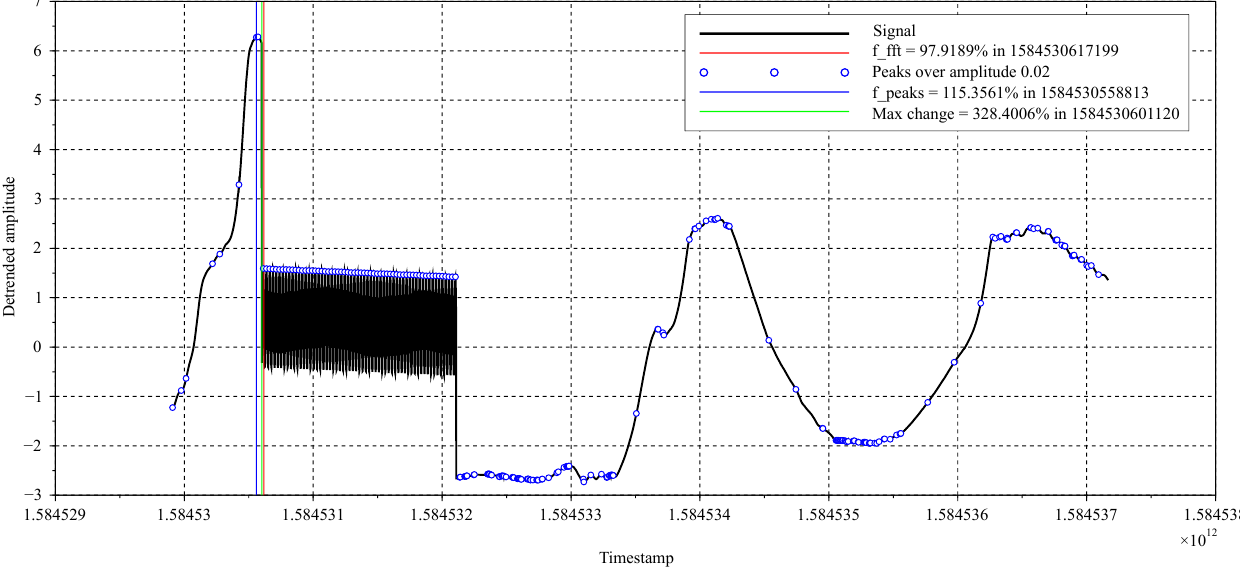
Figure 4. Graphical output from signalCheck() function